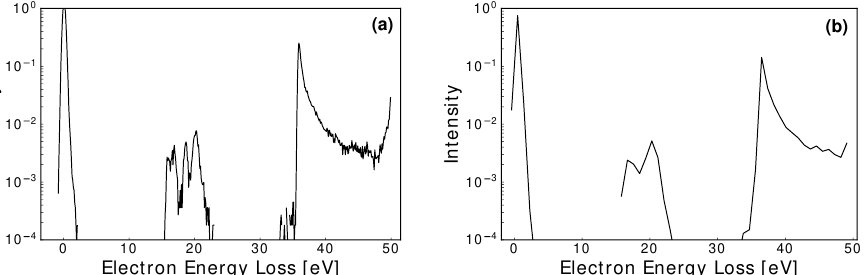
Figure 2. An example EELS comparison between a 0.1 eV energy resolution ( a ) and a 0.9 eV energy resolution ( b ), for an initial electron energy of 50 eV scattering from neon [90]. Significant information is lost at 0.9 eV, especially when the peaks are in close